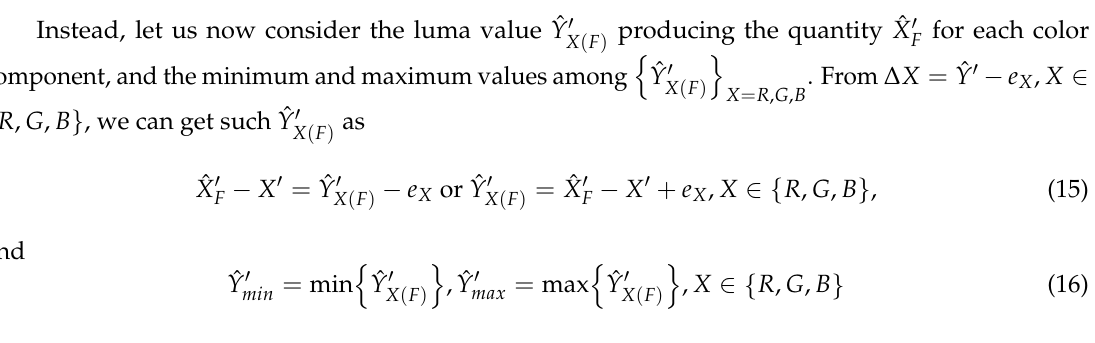
Figure 2. A linear approximation of the electro-optical transfer function (EOTF) and the quantities in (14).